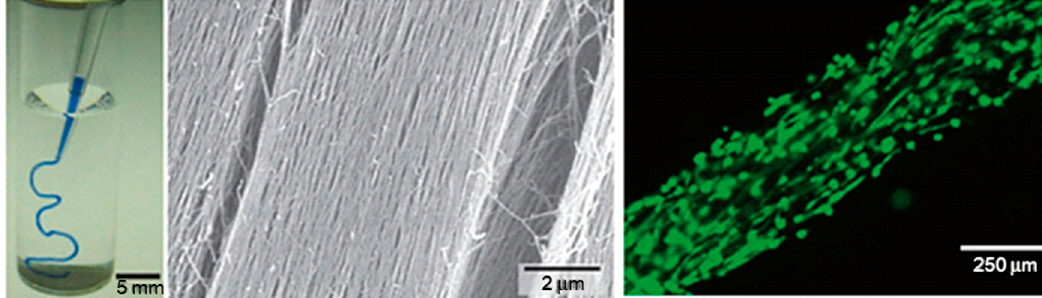
Figure 2. Formation of a noodle-like string from a peptide-amphiphile, colored with tryptan blue. ( left ) Pipetting was performed in a phosphate-buffered saline solution. ( middle ) SEM micrograph showing the highly aligned nanofiber bundles that constitutes the gel string. Gel strings can be used to encapsulate and align cells (e.g., human mesenchymal stem cells, hMSCs) along the axis of the gel ( right ). Adapted and reprinted with permission from [51].